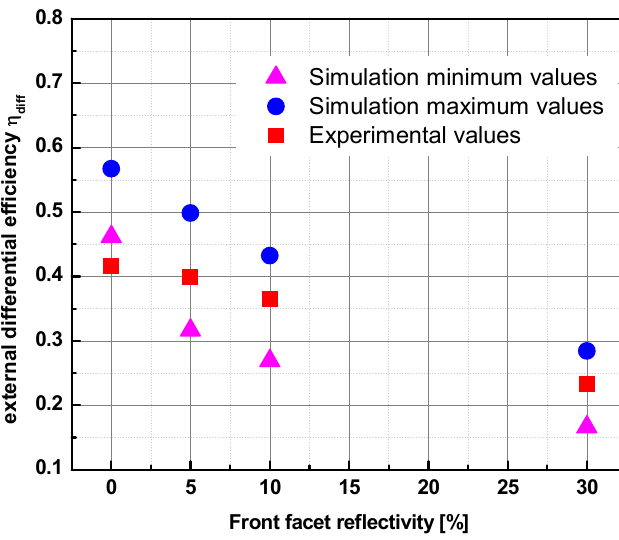
Figure 5. External differential efficiency of 780 nm DFB diode laser at 50 mW output power vs. front facet reflectivity: Minimum simulation values (pink solid triangle), maximum simulation values (blue solid circle), and experimental values (red solid square).